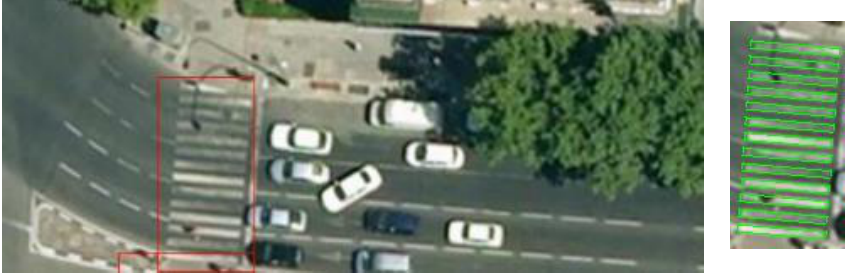
Figure 20. Reconstruction of blurred zebra crossing.